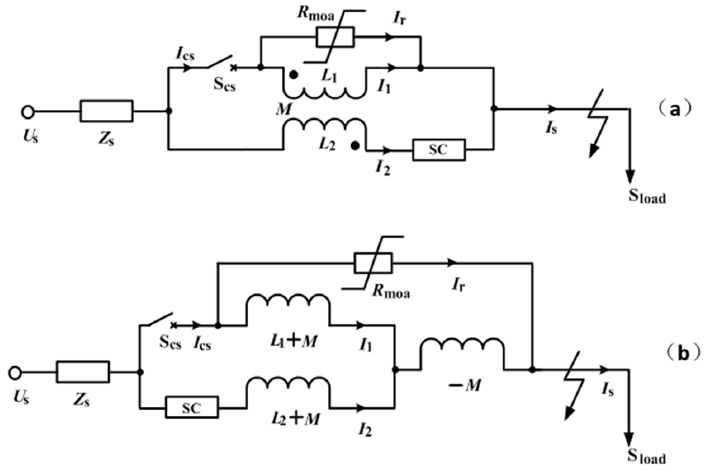
Figure 1. Flux ‐ coupling ‐ type SFCL. ( a ) Main connection and ( b ) electrical equivalent